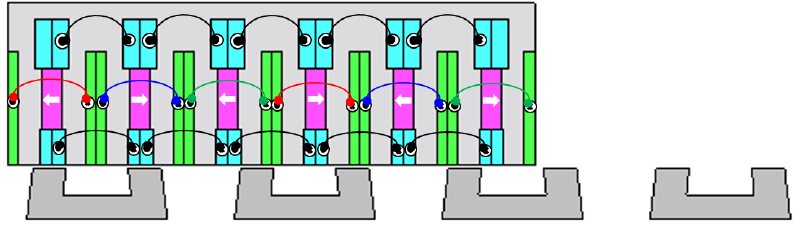
Figure 1. 2D view of the proposed model.